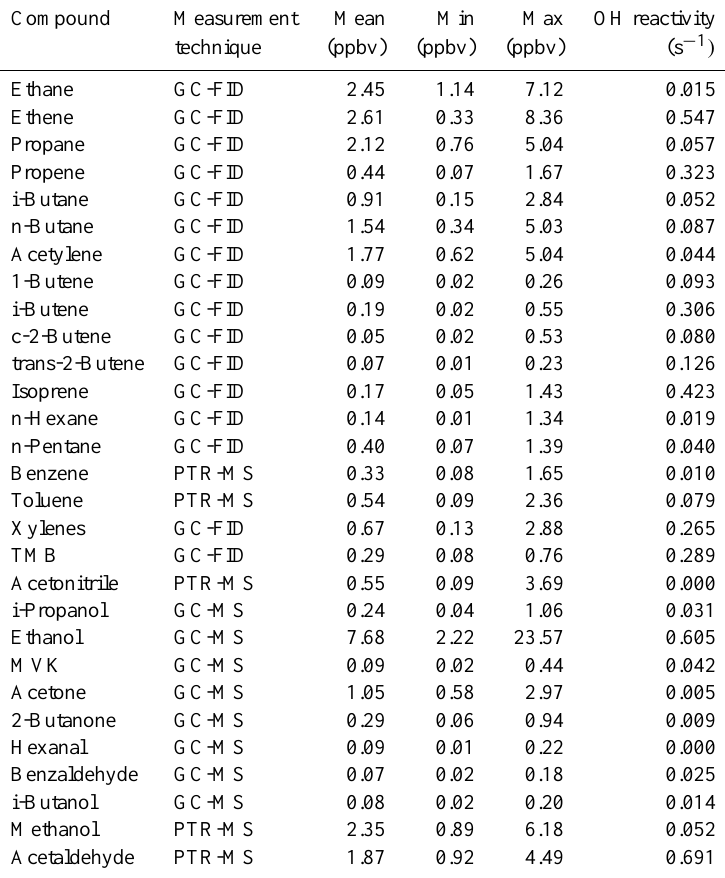
Table 2. Mean values of the main volatile-organic-compounds (VOC) volume mixing ratio measured during the campaign (TMB, trimethyl- benzene; MVK, methyl vinyl